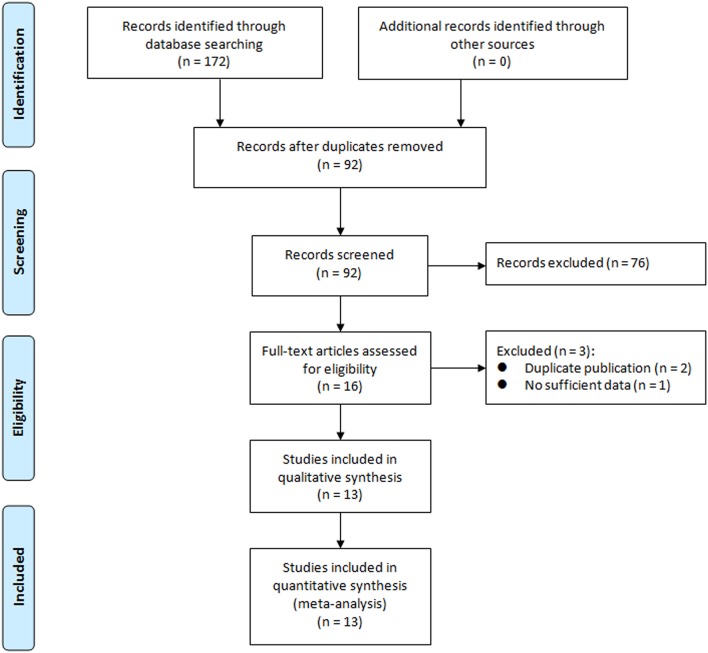
Flowchart of study selection process.